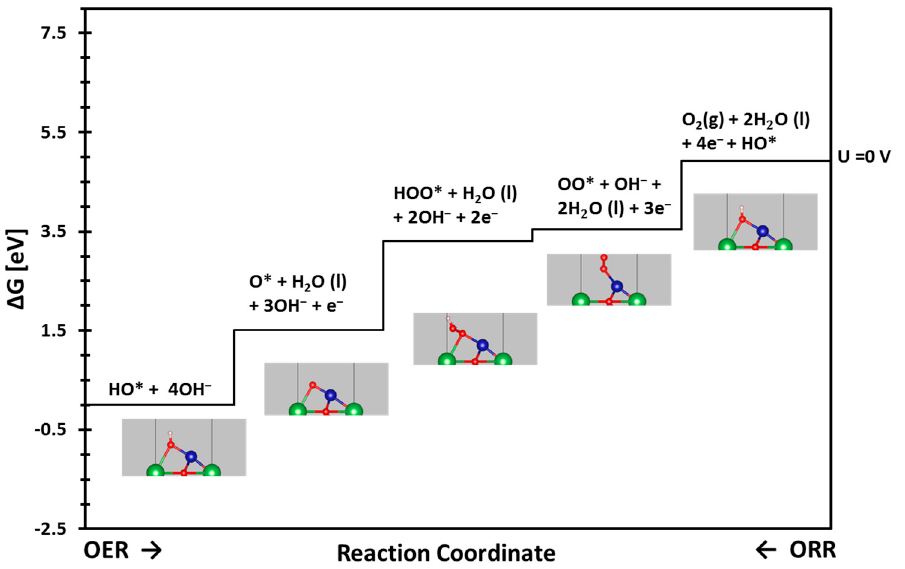
Figure 1. OER and ORR energy profile in alkali medium. OER occurs from left to right, and ORR occurs from right to left on the profile. Red, purple, green, and white color atoms are O, Mn, La, and H, respectively.